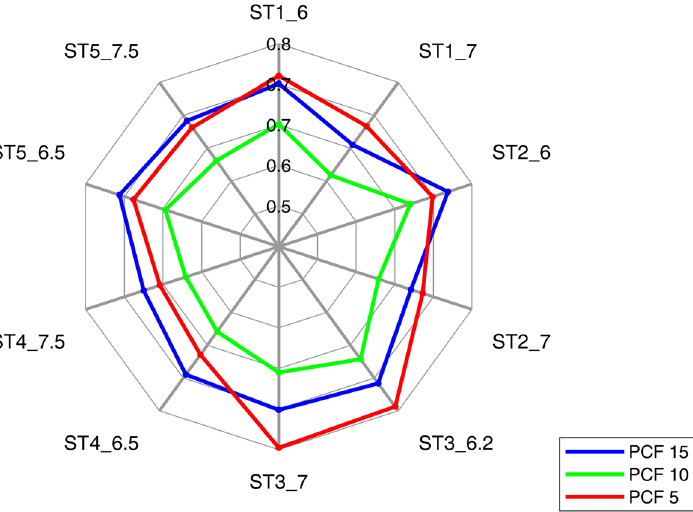
Figure 4. Ideal correction factors for screw pull-out determined from experimental data on different material densities.